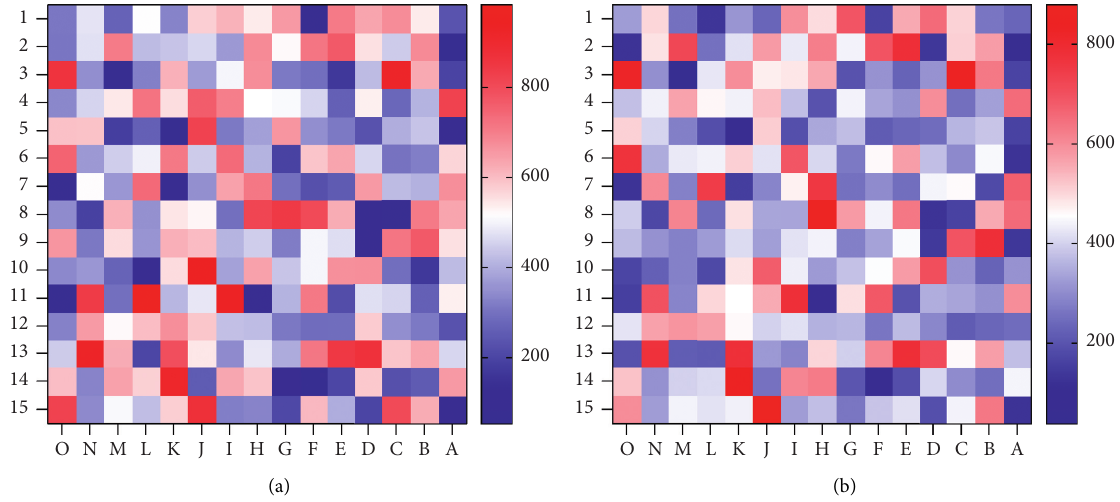
Figure 10: Targeted market evaluation form segmented by psychological factors. (a) Control group A. (b) Control group